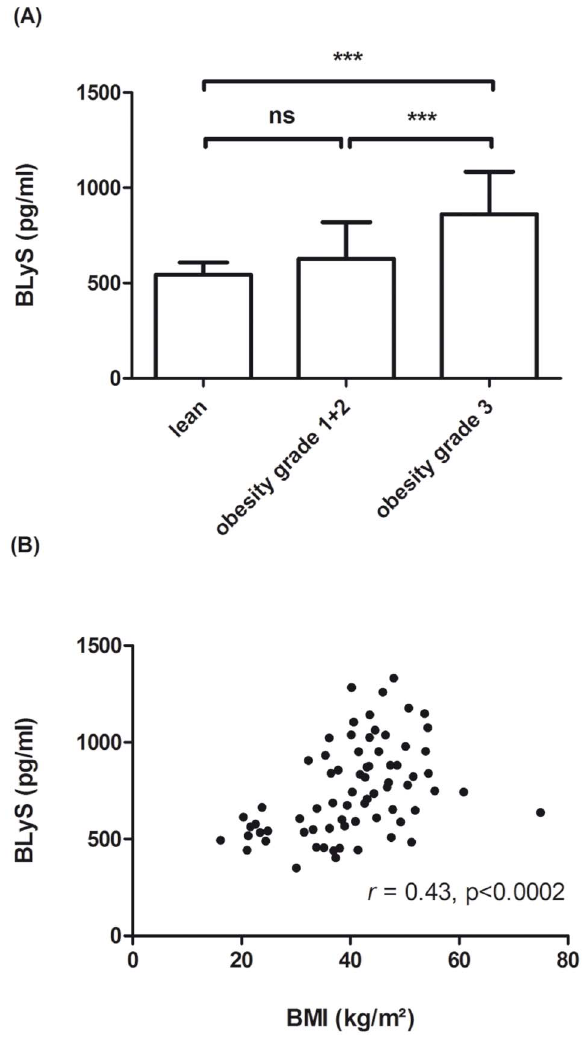
Figure 3. BLyS serum levels in human obesity. (A) represents significant differences between different grades of obesity (grade 1 + 2 (BMI $ 30 to , 40 kg/m 2 ), n=20 and grade 3 (BMI $ 40 kg/m 2 ), n=42) and normal-weight ((BMI # 25 kg/m 2 ), n=10) human control subjects. (B) shows the correlation ( r =0.43, p , 0.0002) between BLyS serum levels and BMI of n=72 human subjects used in this study. Data in this figure are shown as means + SD.